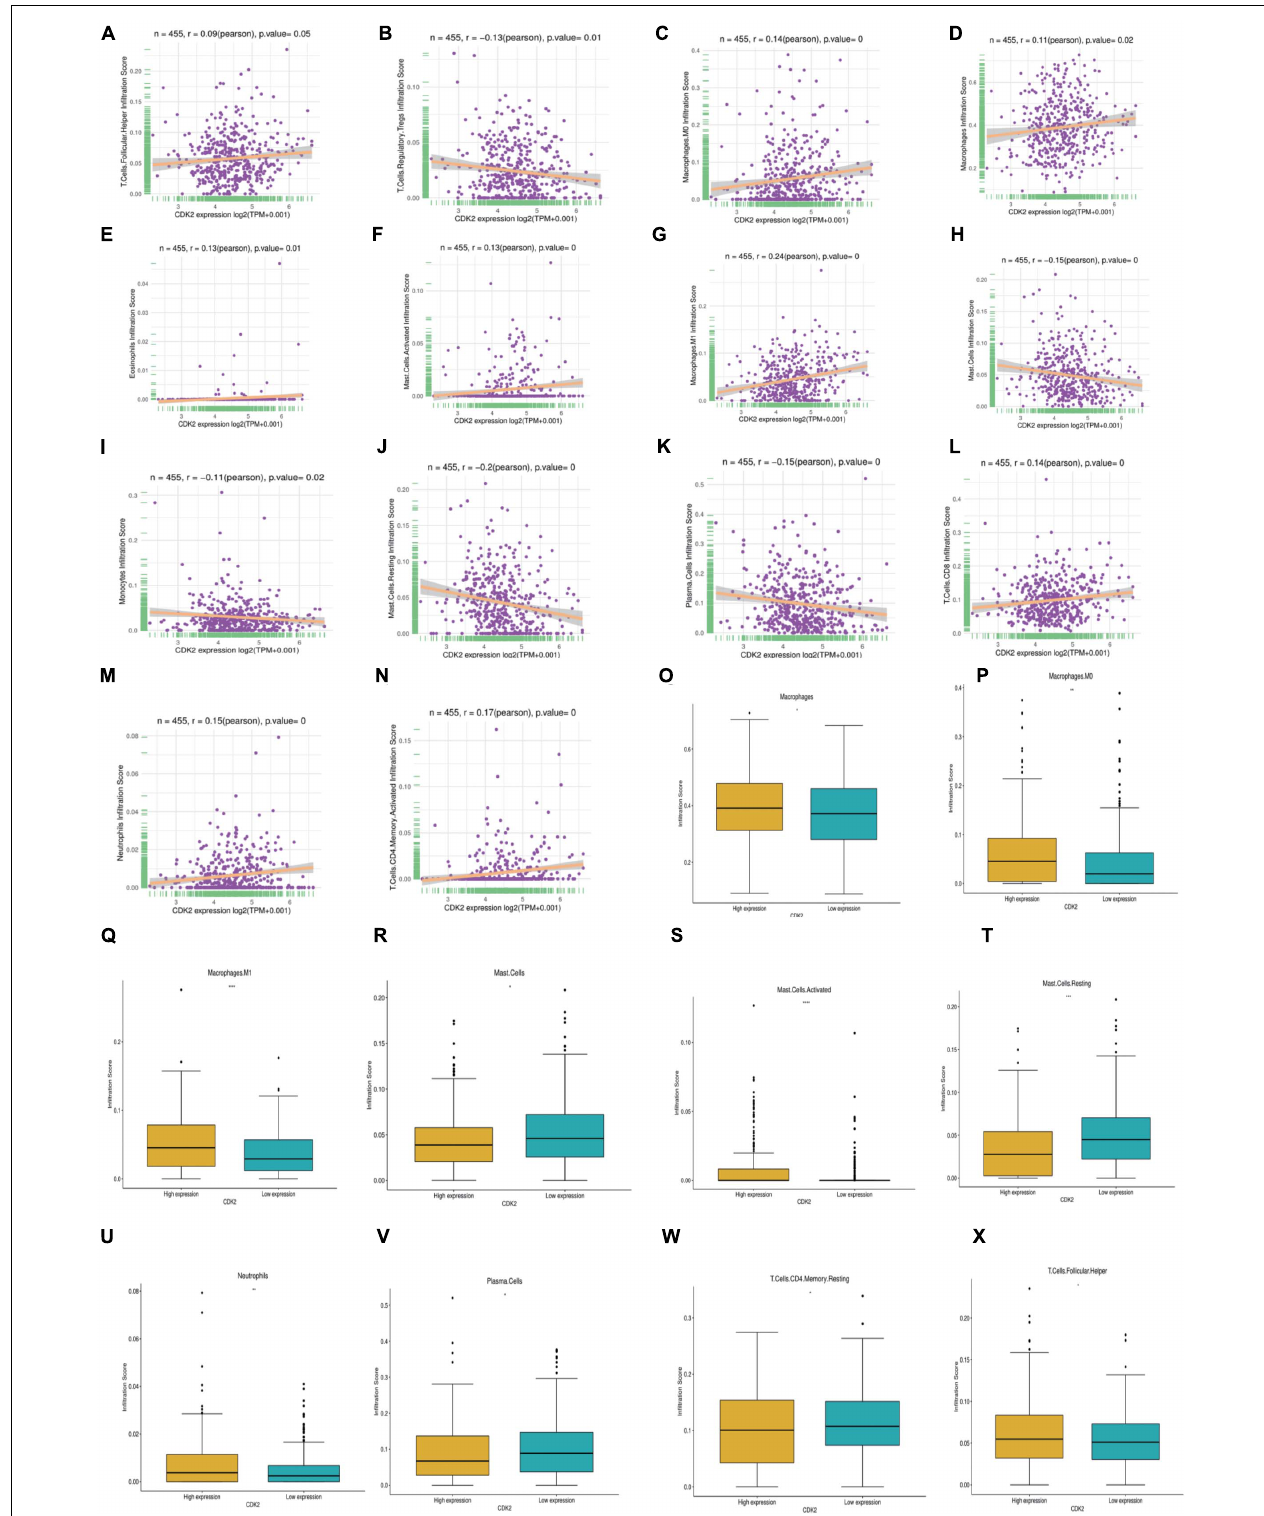
FIGURE 9 | Characteristics of CDK2 immune cells infiltration. (A–N) 14 immune cells (T cells Follicular, T cells Regulatory Tregs, Macrophages.M0, Macrophages, Eosinophils, Mast cells activated, Macrophages M1, Mast cells, Monocytes, Mast cells Resting, Plasma cells, T cells CD8, Neutrophils, T cells CD4) were closely related to the expression of CDK2 ( P ≤ 0.05). (O–X) In different CDK2 expression groups, the expression of immune cells had systematic differences ( P < 0.05).